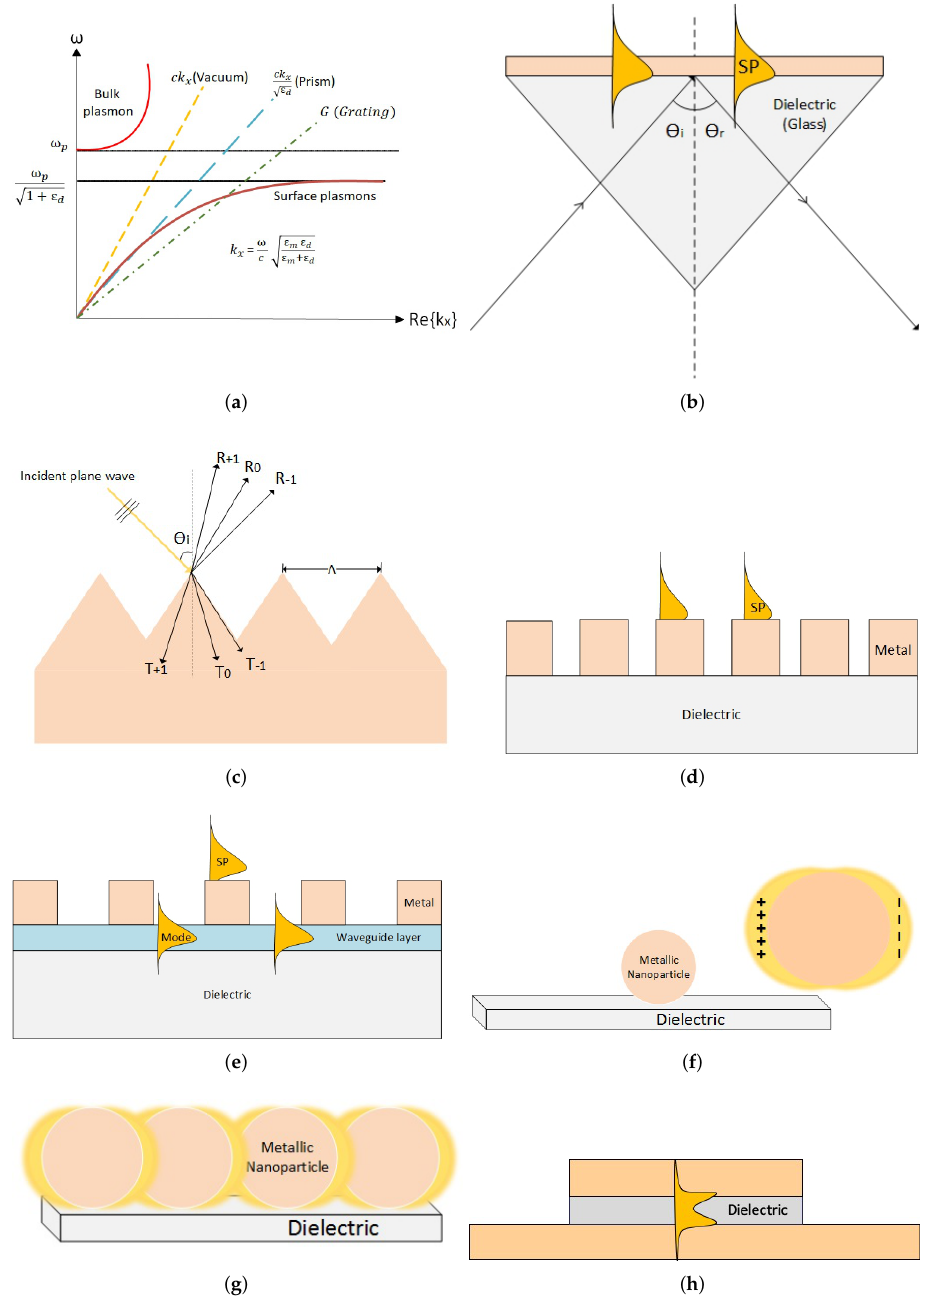
Figure 3. Generating Plasmons. ( a ) Dispersion relation of surface plasmons compared to light in vacuum and in the dielectric medium. Incident light on a ( b ) glass prism with gold sputtered on one of its faces, SPP propagates along the glass and Au interface ( c ) Diffraction grating with period Λ ( d ) shows diffraction grating with varying refractive index and path for the incident light ( e ) represent a GMR-based grating ( f ) The reaction of single nano-particle on dielectric to the incident light ( g ) shows the reaction of lattice of nanoparticles to the incident angle and ( h ) GSP resonance, a special kind of FP-cavity with thin dielectric film and one metallic truncated film on the